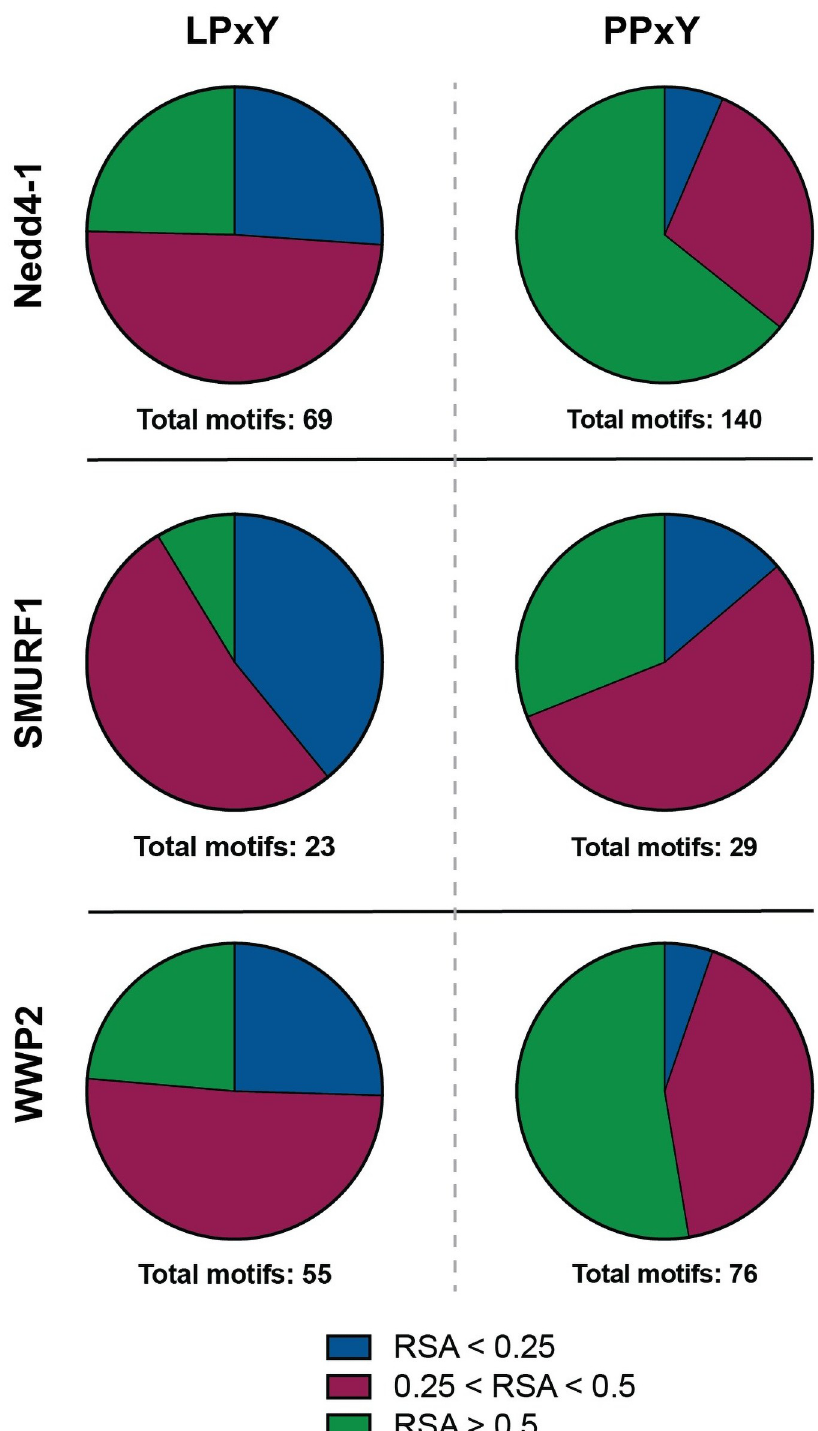
Fig 4. Relative solvent accessible surface area (RSA) of PY motifs from the Nedd4-1, SMURF1, and WWP2 interactome reveals that PPxY motifs are more solvent accessible than LPxY motifs. RSA, calculated with NetSurfP-2.0 bioinformatic algorithm [51], is determined by the ratio of total accessible surface area of a residue in the protein relative to maximum accessible surface area of the residue itself. A score of 0.25 or lower is indicative of “buried” residues, or those that would be inaccessible for engaging in protein-protein interactions. Buried residues